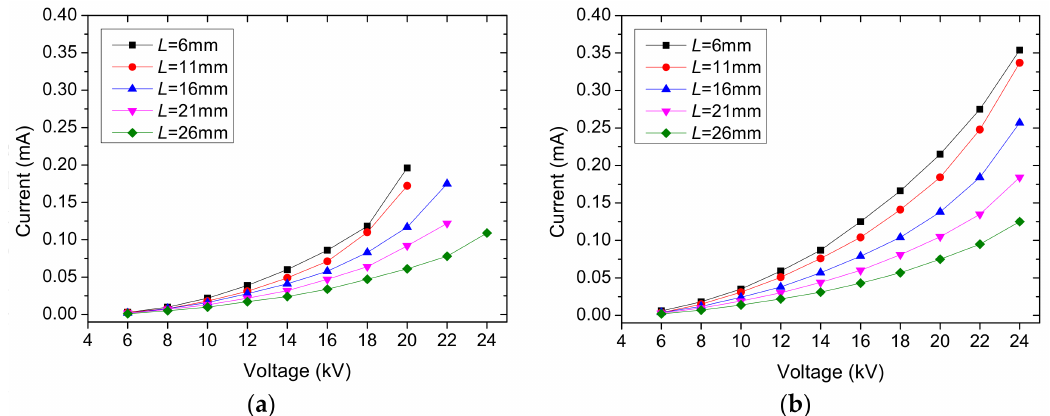
Figure 8. Variation of discharge current with the applied voltage with different needle-ring distances for four needles: ( a ) positive corona discharge; and ( b ) negative discharge.